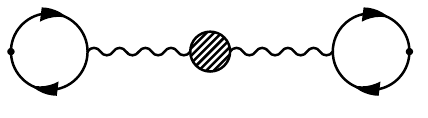
Figure 3 . Diagram contributing to h j 1 j 1 i